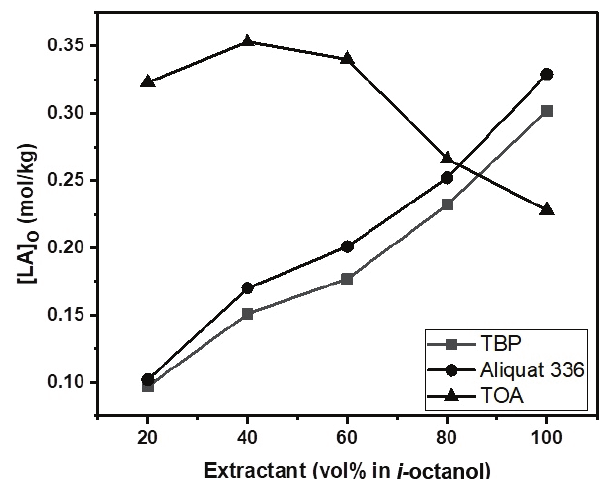
Fig. 3 – Effect of the type of extractant and its volume % in the mixtures with i-octanol diluent on the extraction efficiency of levulinic acid